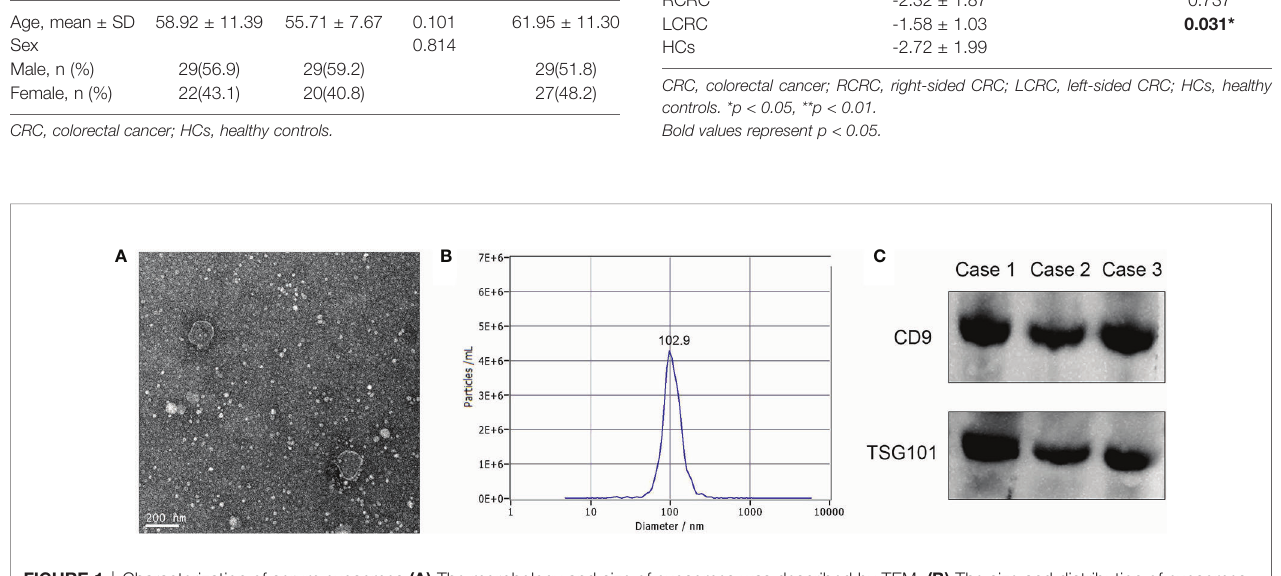
FIGURE 1 | Characterization of serum exosomes (A) The morphology and size of exosomes was described by TEM, (B) The size and distribution of exosomes were determined using NTA, with 102.9 nm in diameter on average, (C) Western blot: analysis for typical exosome markers, CD9 and TSG101, which are enriched in exosomes.